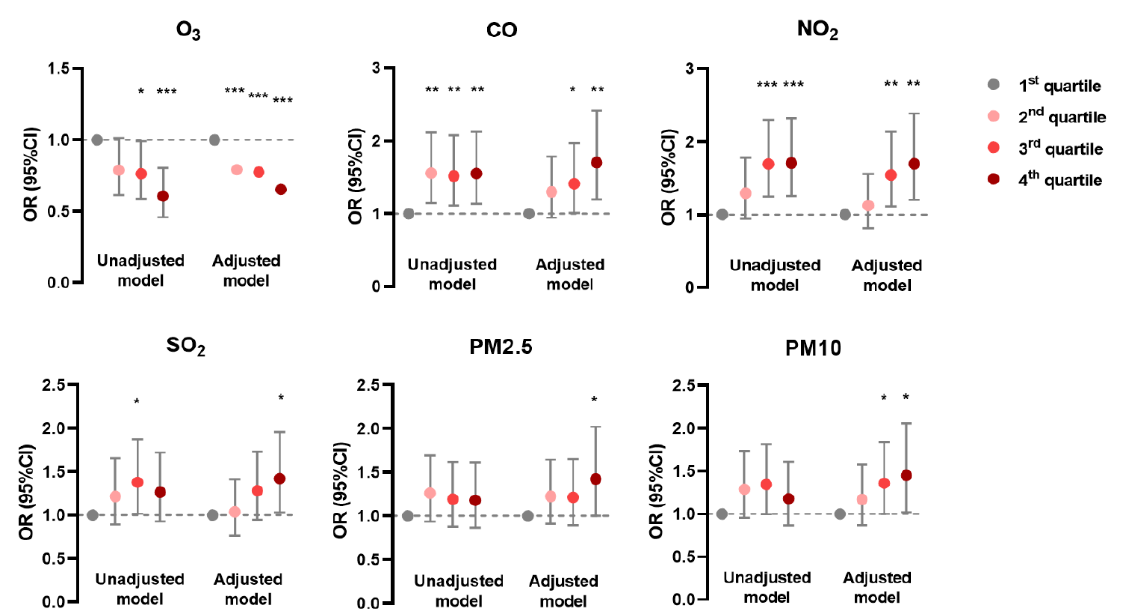
Figure 1. Association between atopic dermatitis and adjusted daily dose of ambient air pollutants. The unadjusted model describes the crude OR; the adjusted model was adjusted for demographic variables, behavioral habits, and environmental factors. * 0.01 < p < 0.05; ** 0.001 < p < 0.01; *** p < 0.001.